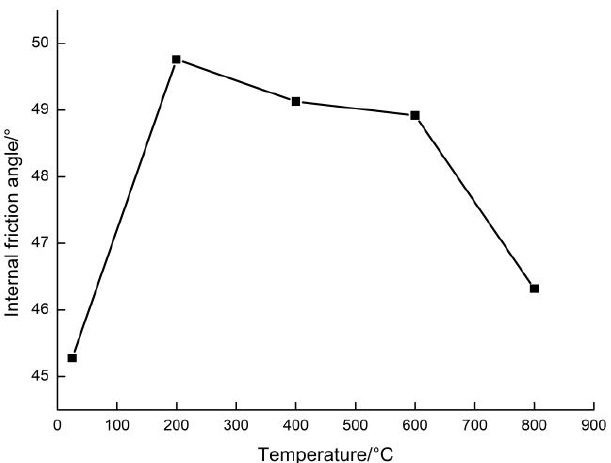
Figure 8. Relationship between internal friction angle and temperature in sandstone.